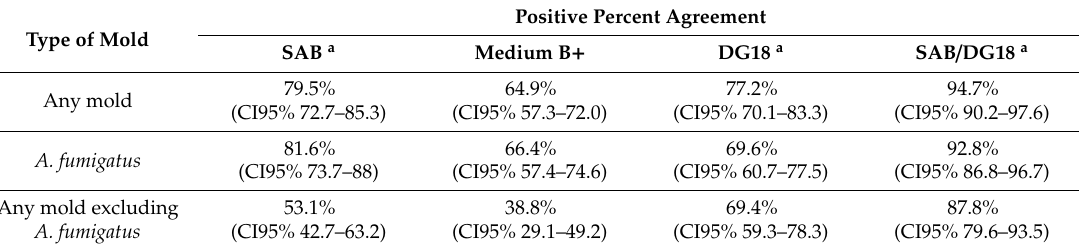
Table 3. Positive percent agreement of individual culture media with all